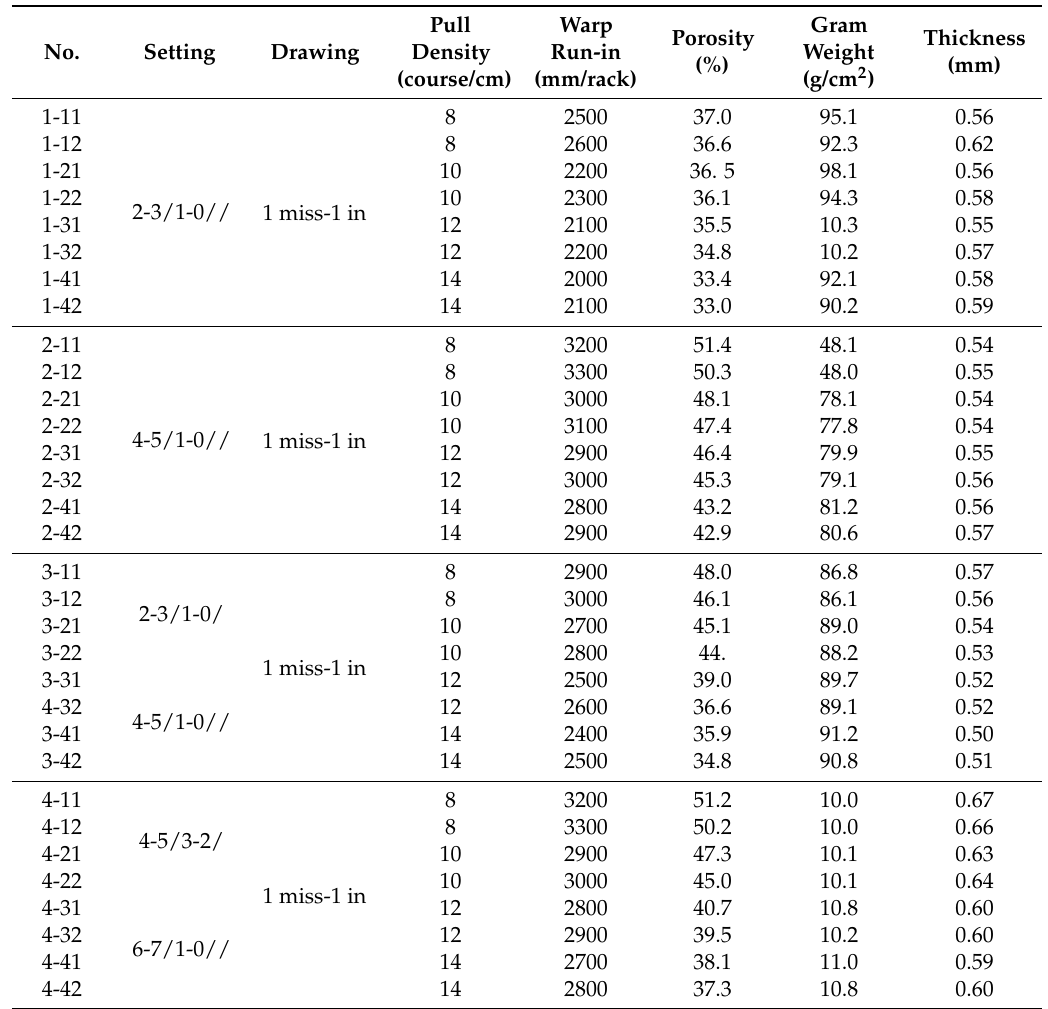
Figure 1. Stitch patterns used for ( a ) fabric 1#; ( b ) fabric 2#; ( c ) fabric 3# and ( d ) fabric 4#. Table 1. Structure parameters.